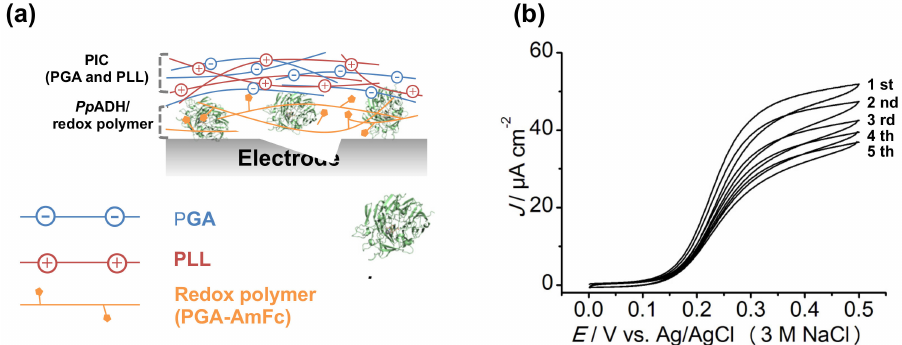
Figure 7. ( a ) Schematic illustration of the Pp ADH-modified GCE with the polyion complex and PGA-AmFc. ( b ) Cyclic voltammograms of the Pp ADH, PGA-AmFc, and polyion complex-modified GCE from 1st scan to 5th scan in 50 mM CHES (pH = 9.0) containing 30 mM ethylamine and 100